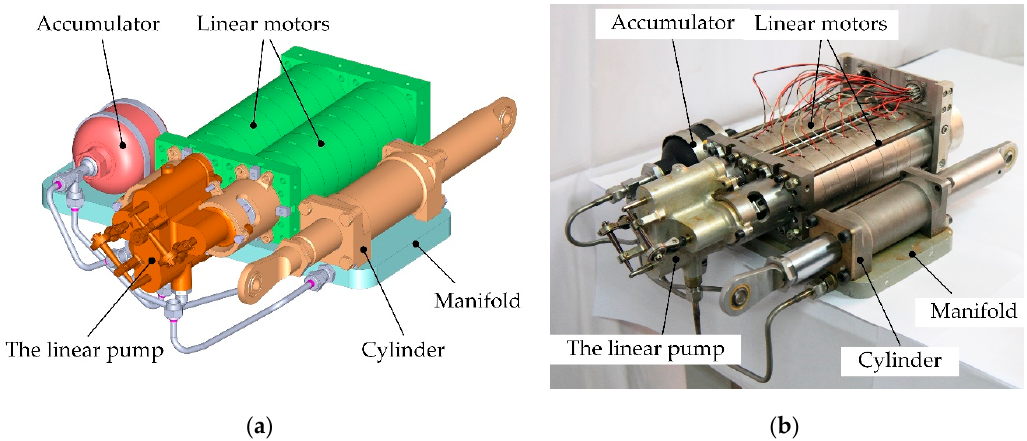
Figure 5. The actuator prototype outline: ( a ) mechanical model of the actuator; ( b ) prototype of the actuator.